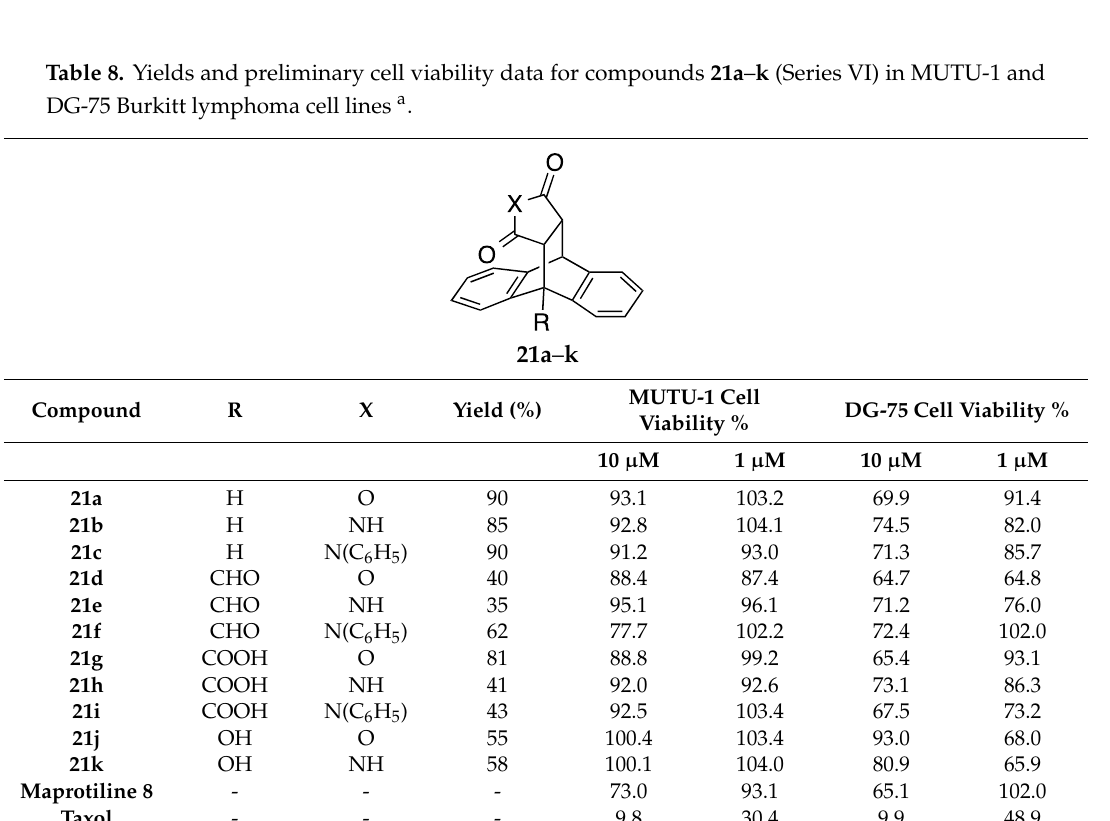
Table 9. Yields and preliminary cell viability data for compounds 23a – k (Series VII) in MUTU-1 and DG- 75 Burkitt lymphoma cell lines a . 23a –